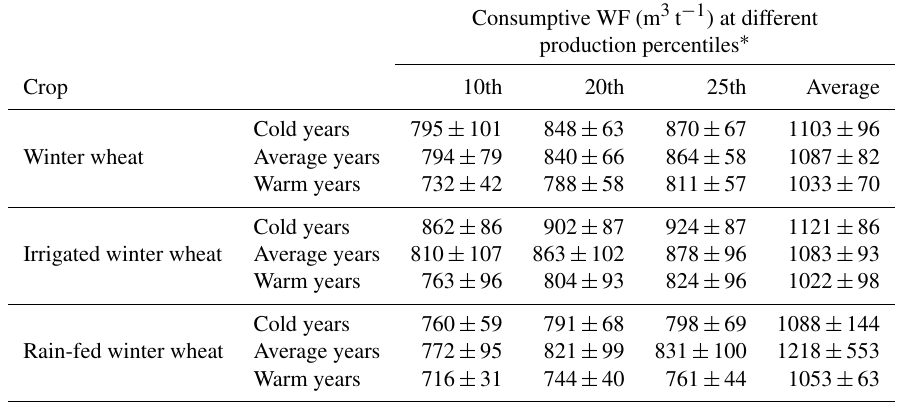
Table 3. National consumptive water footprint (WF) benchmarks (m 3 t − 1 ) of winter wheat for relative cold, warm, and average years in China.